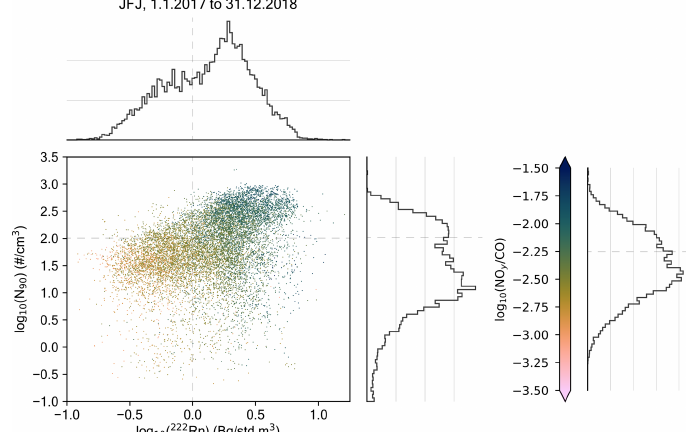
Figure A3. A scatter plot of simultaneous radon-222 ( 222 Rn) concentrations, particle concentrations with a mobility diameter larger than 90nm (N 90 ), and the ratio of reactive nitrogen species to carbon monoxide (NO y / CO) as color code, between January 2017 and Decem- ber 2018. These are all tracers used to detect boundary layer intrusions (BLI) at mountaintop sites, where the gray dashed lines indicate the thresholds stated in literature (see Griffiths et al., 2014; Herrmann et al., 2015; Zanis et al., 2007, for more information), where low 222 Rn and N 90 concentrations and low NO y / CO ratios are indicative of free tropospheric air masses (FT). We argue that N 90 concentrations above the threshold are indicative for BLI; however, low N 90 concentrations do not imply FT conditions, as in the lower right quadrant both 222 Rn and NO y / CO suggest BLI despite N 90 concentrations below its threshold.